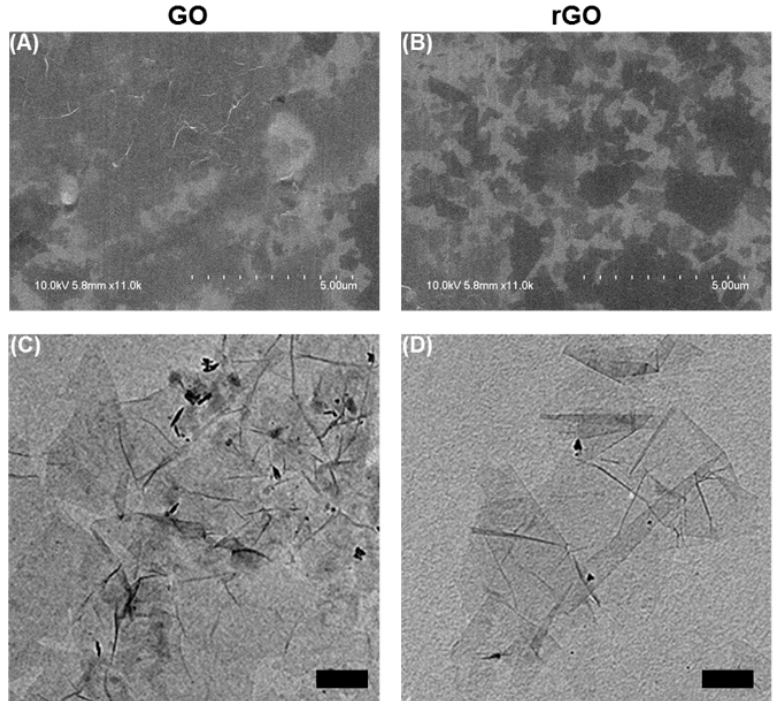
Figure 1. Top-view scanning electron microscopic (SEM) images of the ( A ) graphene oxide (GO) and ( B ) reduced graphene oxide (rGO), high resolution-transmission electron microscopic (HR-TEM) images of the ( C ) GO and ( D ) rGO.